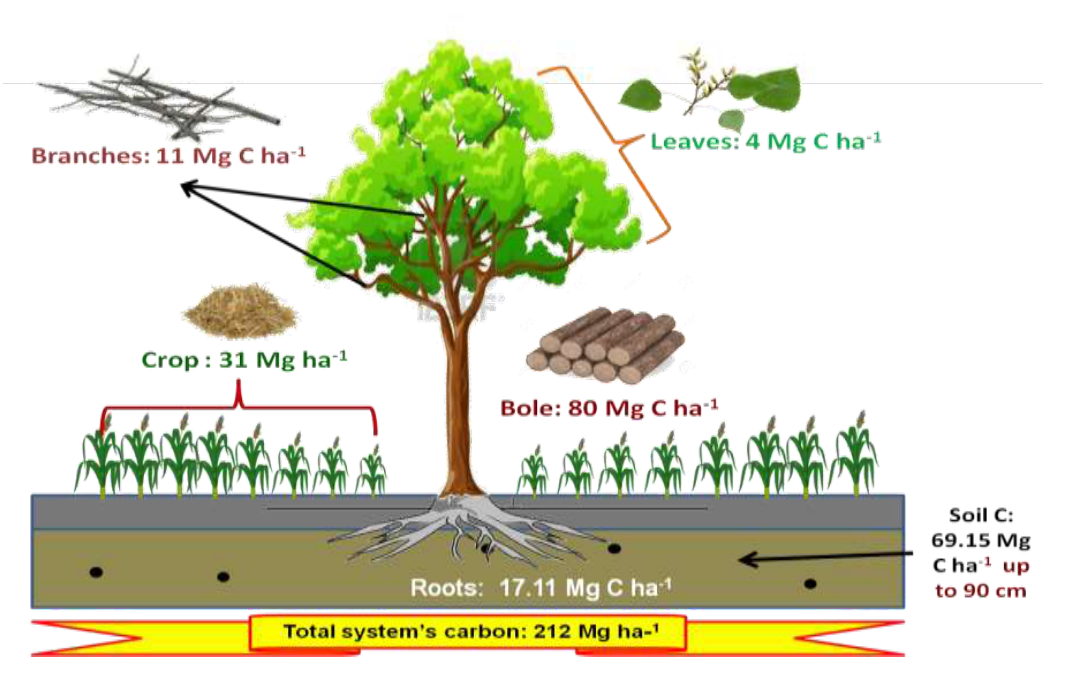
Figure 4. Total carbon stock of sorghum-berseem crop rotation in poplar (5 × 4 m) over a complete rotation of 8 years.